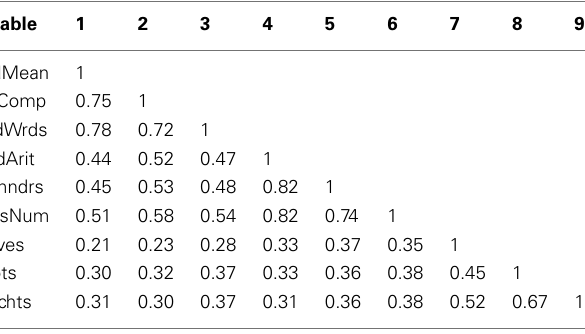
Table 1 | Population correlation matrix.